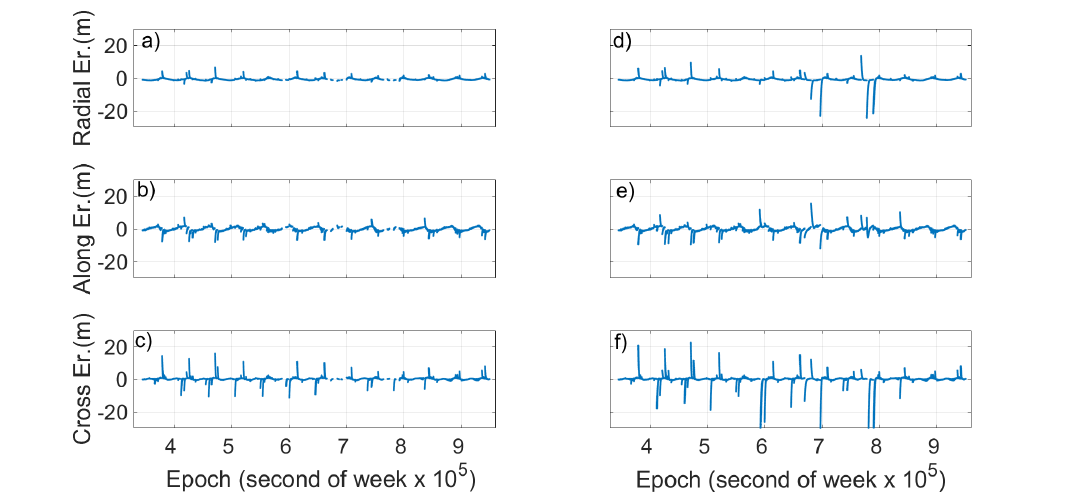
Figure 14. Comparison of radial, along and cross error for Doresa (E18) obtained by using validity time threshold of: 1800 s ( left ); and 10,800 s ( right ). To have a better readability, the maximum value of errors is limited to 30 m. Errors that exceed this threshold relate to the cross component with a maximum error of − 173.1 m ( f ). Figure refers to DOYs